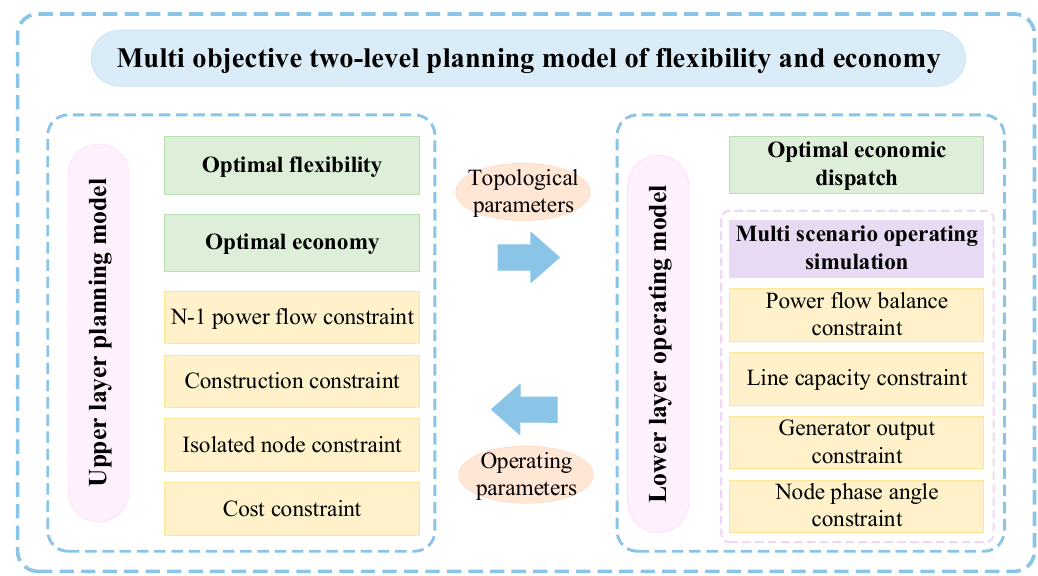
Figure 1. Two-level planning model.